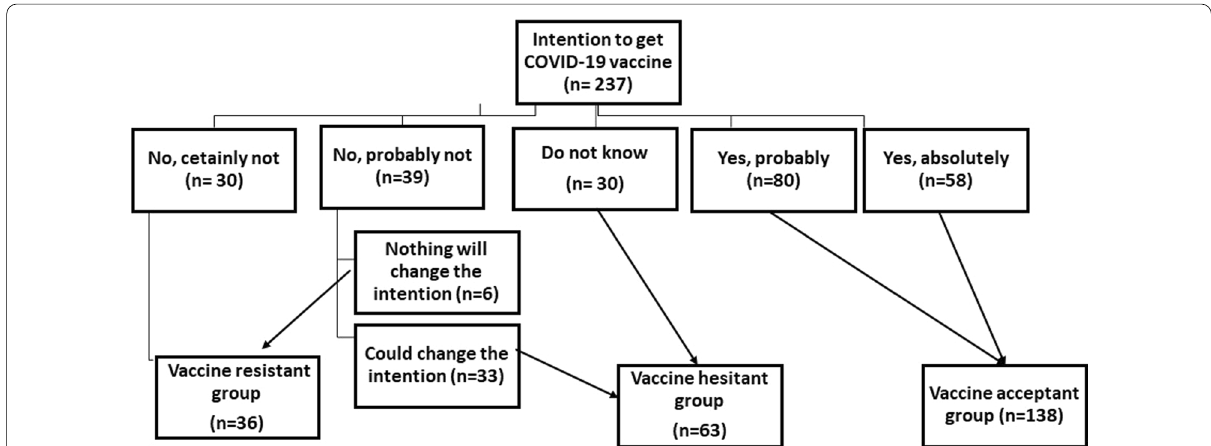
Fig. 1 Classification of the participants according to intention to receive COVID-19 vaccine (resistant, hesitant, and